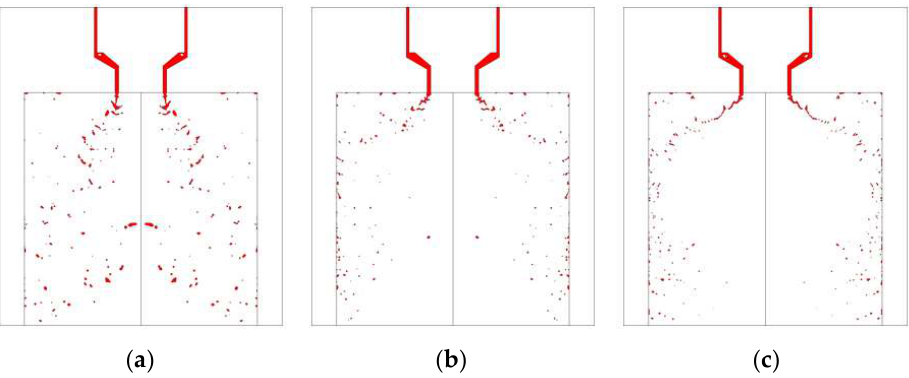
Figure 9. Comparison of NTO spray development at 5 ms under different switch speeds: ( a ) 0.125 m/s,